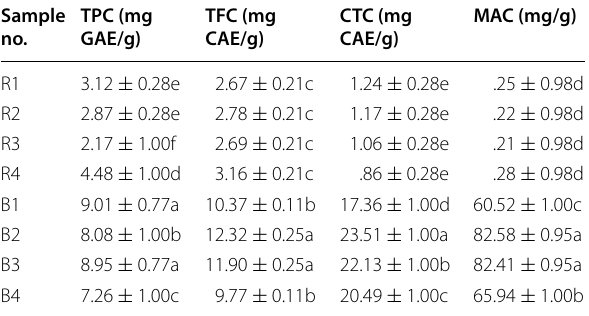
Table 2 TPC, TFC, CTC, and MAC of goji